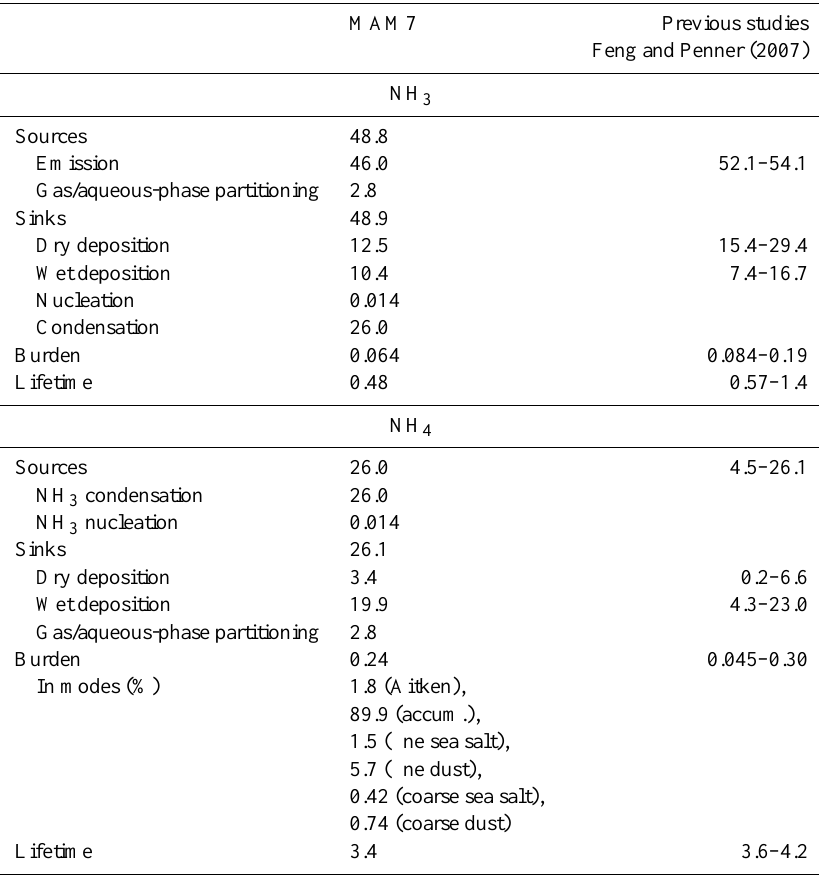
Table 4. Global budgets for NH 3 gas and NH 4 aerosol in MAM7. The range of results from other studies is from Feng and Penner (2007) and references